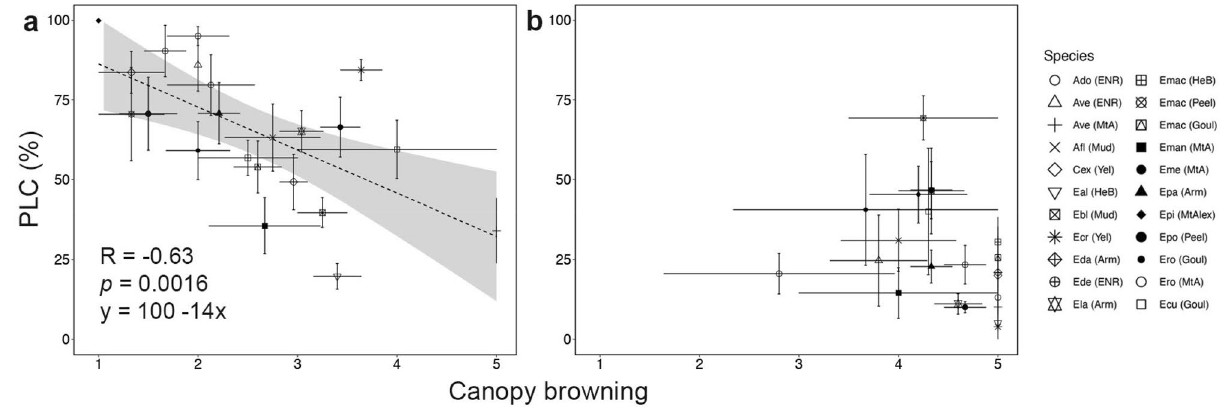
Figure 4. Canopy browning score versus percent loss of conductivity (PLC, %) during drought ( a ) and post- drought ( b ). Each point represents a species at a site; error bars show SE across sampled trees (n = 3–109). The grey shaded area is the confidence interval of the regression line. See references in Table S1 for abbreviations used in the legend.